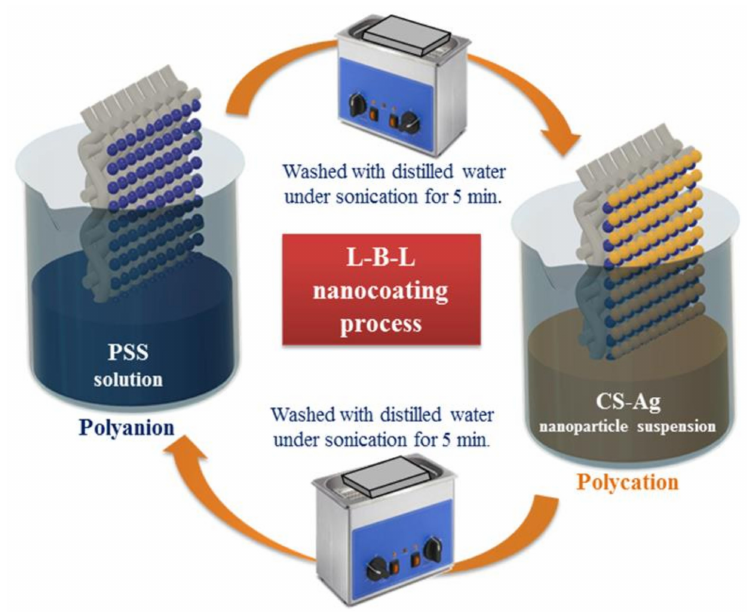
Figure 20. Formation of layers of PSS-CS-Ag on fabric through coating process. Reprinted from [56]. Copyright 2020 with permission from